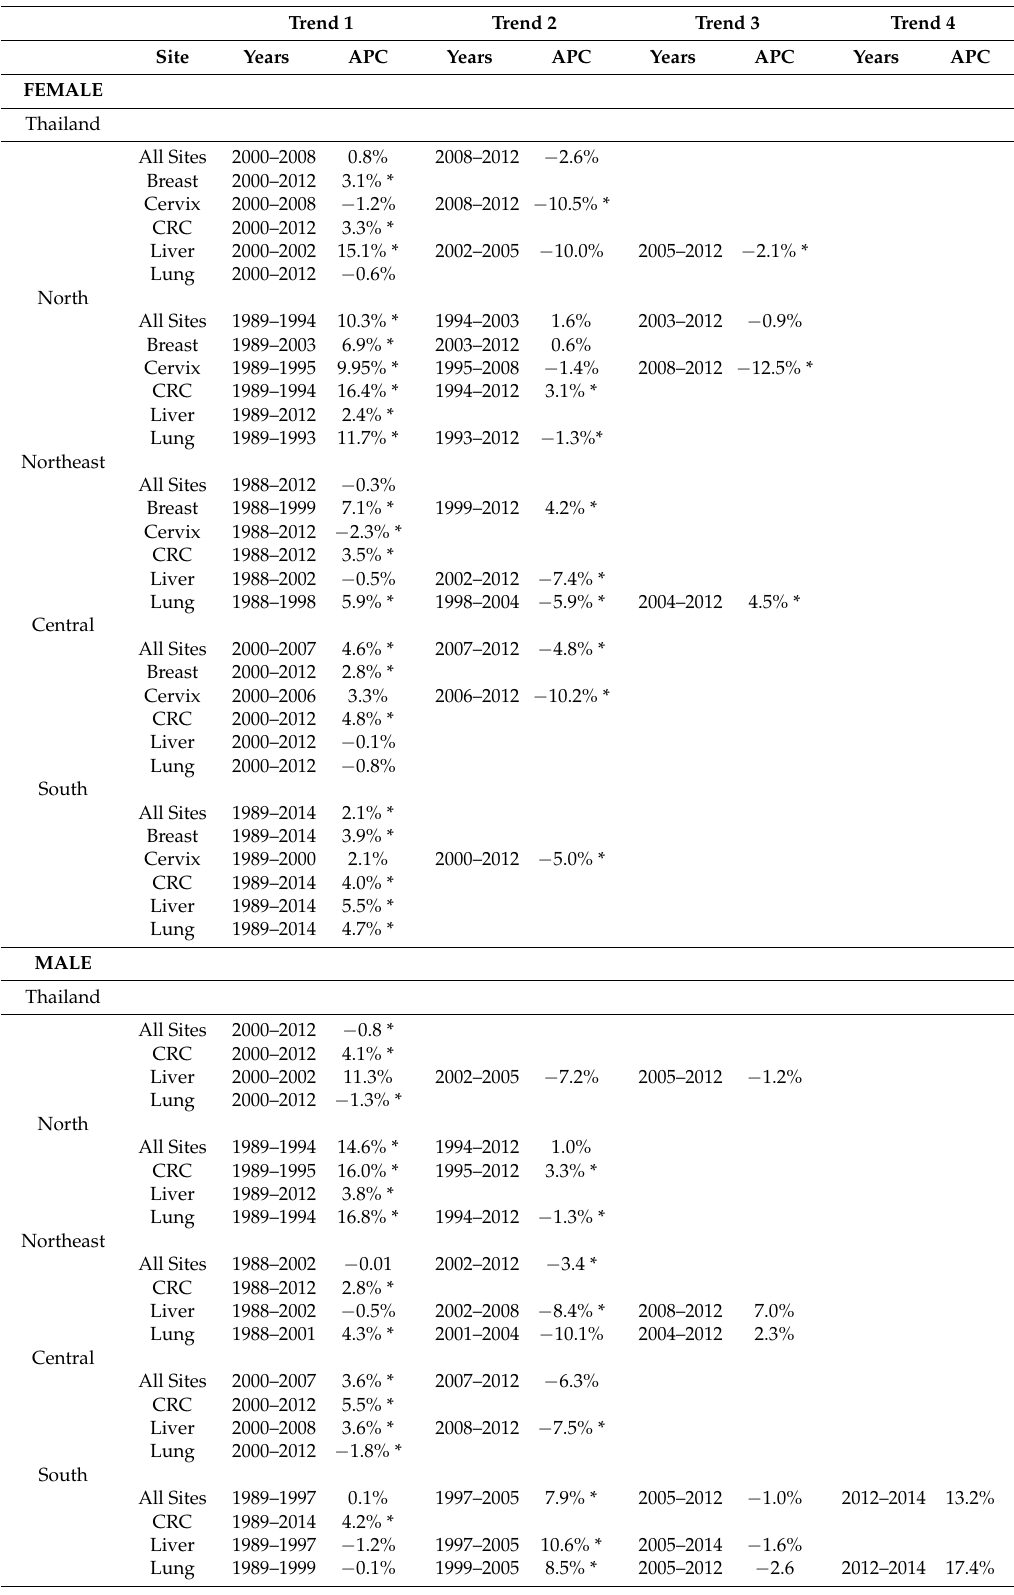
Table 2. National and subnational trends in cancer incidence